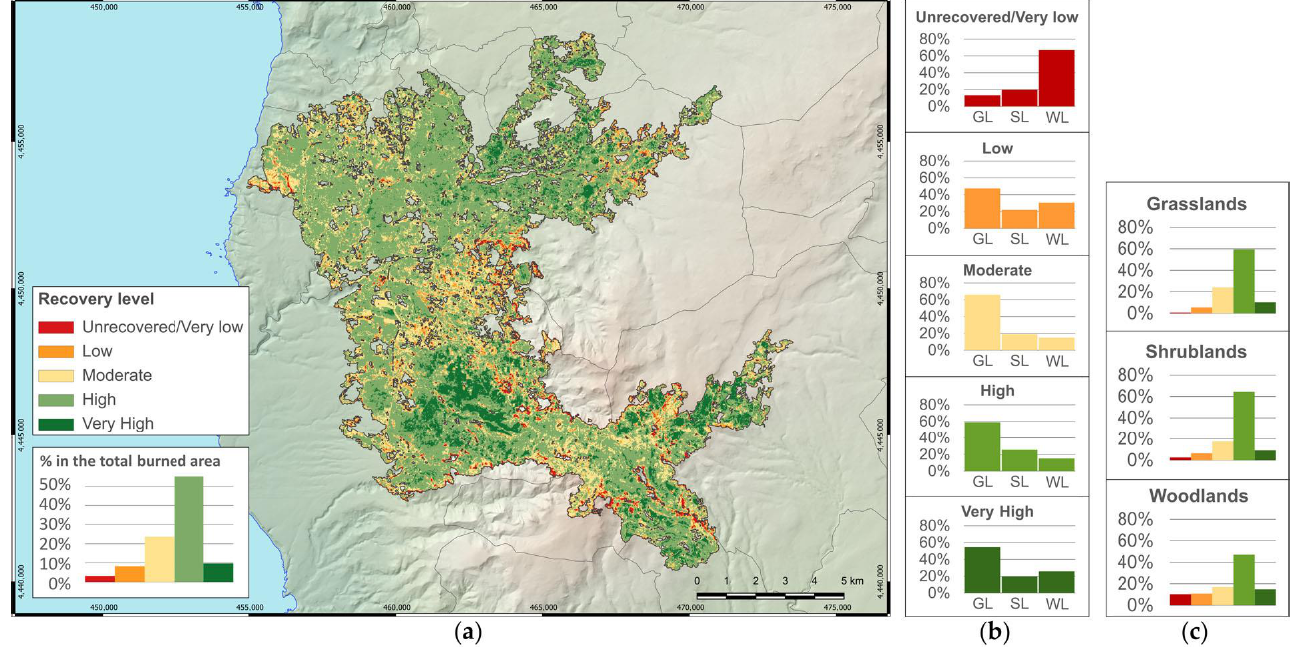
Figure 5. Spectral recovery levels one year after the fire (dNBR post-1yr ). ( a ) Map of recovery levels. The histogram in the map shows the percentage distribution of recovery levels in the total burned area. The reference system is WGS84 – UTM. ( b ) Percentage distribution of recovery levels among grasslands (GL), shrublands (SL), and woodlands (WL). ( c ) Percentage distribution of recovery levels within the vegetation types.